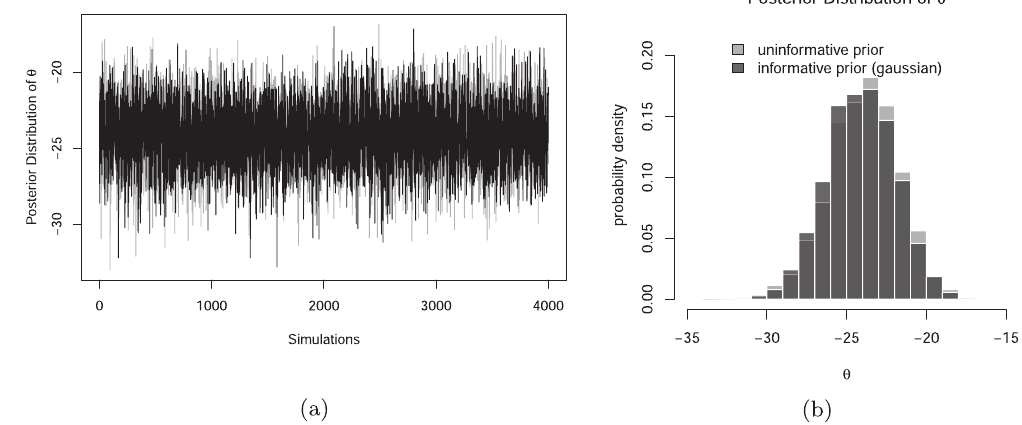
Figure 3. Convergence diagnostics of the HMC simulations – Frank Copula. (a) Trace plot of simulations. (b) Effect of the prior distribution.